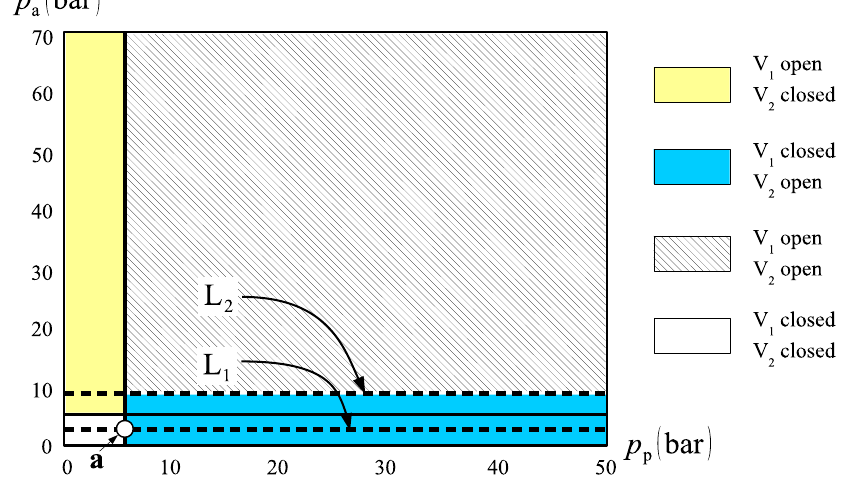
Figure 20. Status of the directional valves V 1 and V 2 for different circuit pressures.